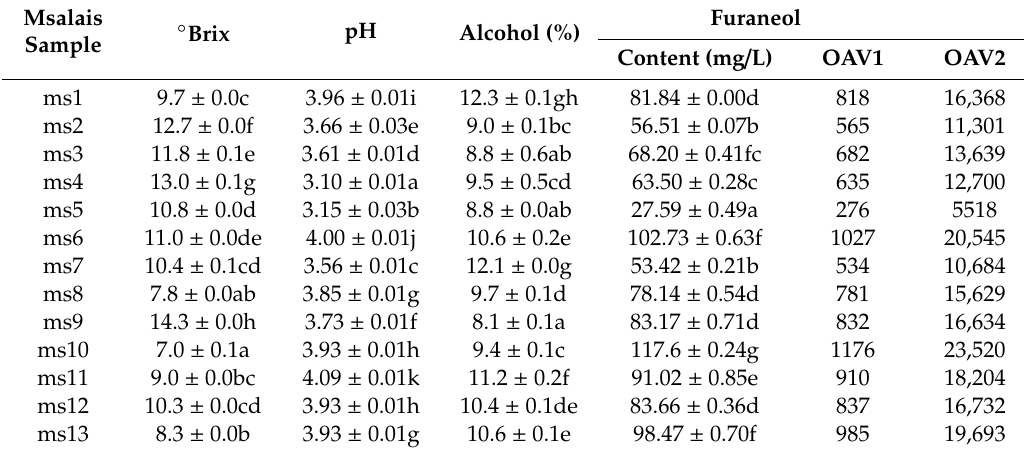
Table 1. Furaneol content of